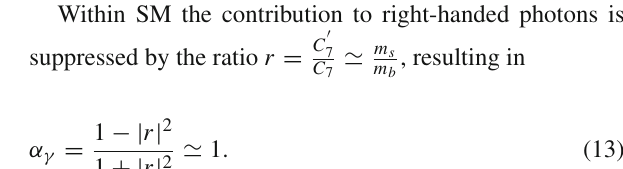
Within SM the contribution to right-handed photons is suppressed by the ratio r = C